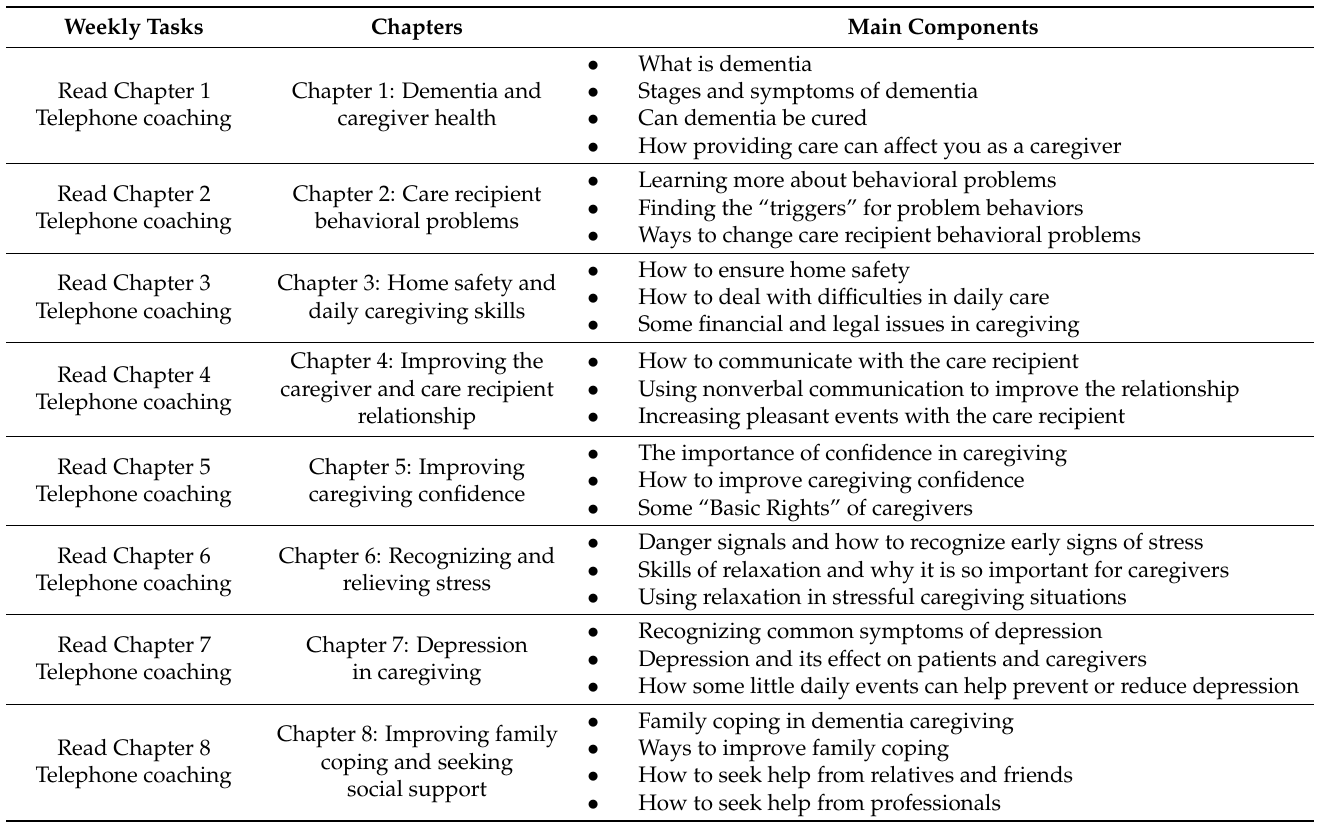
Table 1. The validated evidence-based bibliotherapy